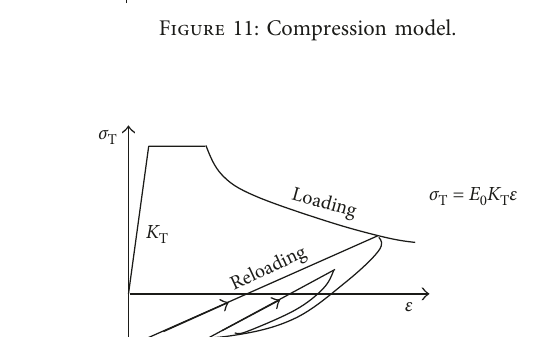
Figure 11: Compression model.